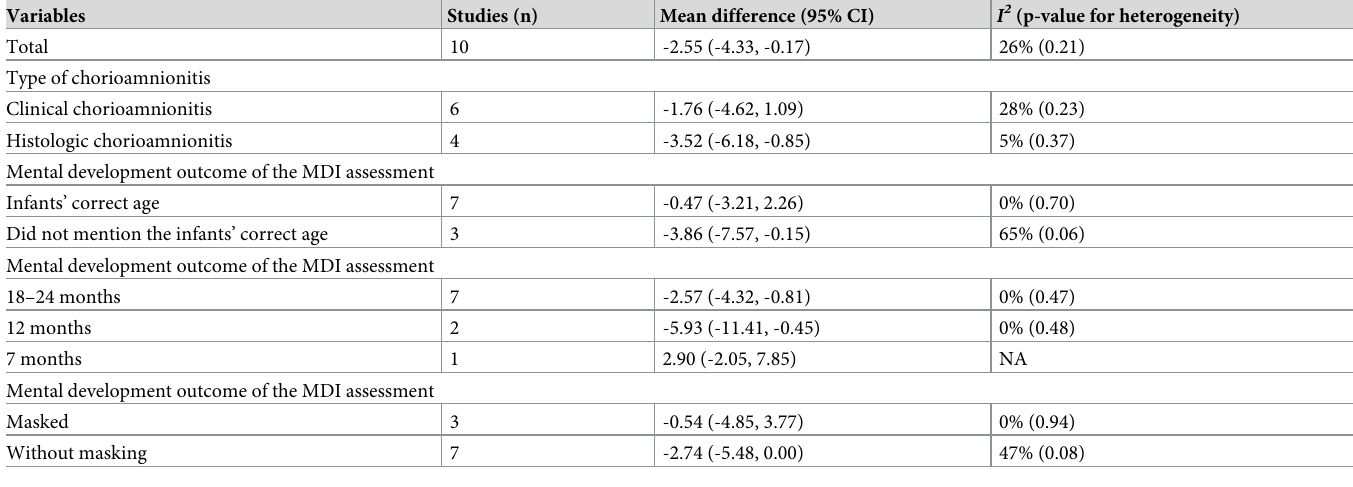
Table 2. Pooled results of the associations between maternal chorioamnionitis and the mental development outcome MDI.